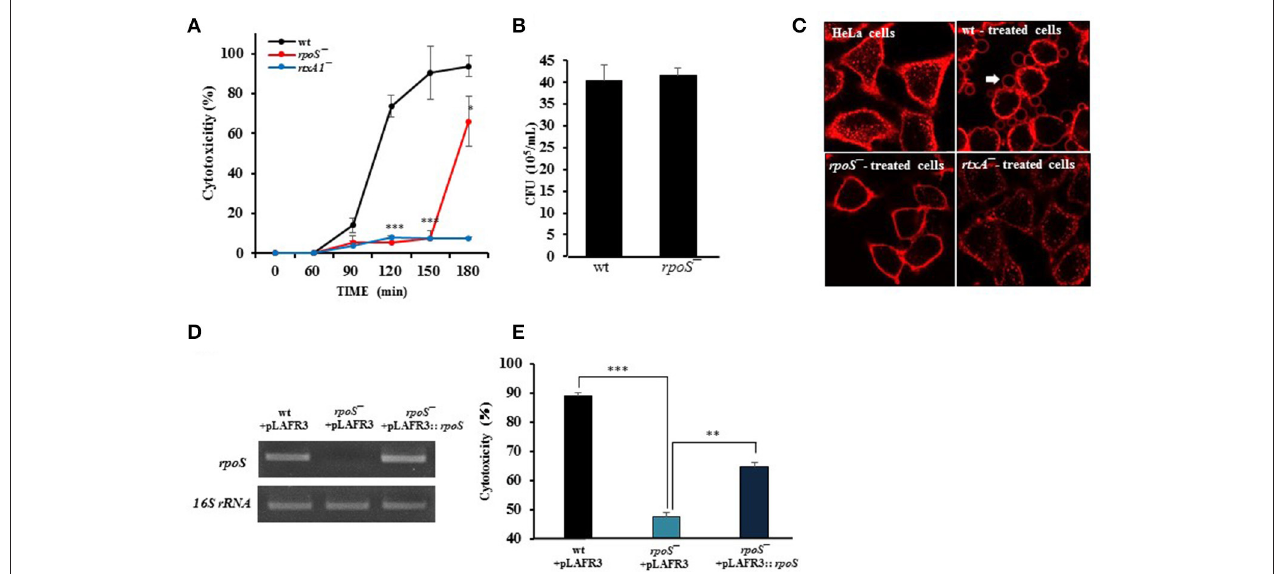
FIGURE 1 | V. vulnificus- induced cytotoxicity and morphological changes in HeLa cells were decreased by an rpoS mutation. (A) HeLa cells in 48-well plates were infected with either V. vulnificus wild-type (wt), an rpoS mutant ( rpoS − ), or an rtxA1 mutant ( rtxA1 − ) strains at an MOI of 20. Lactate dehydrogenase released into the culture supernatant was assayed as a marker of cytotoxicity. (B) HeLa cells in 24-well plates were infected with V. vulnificus strains at an MOI 20 for 120min. The bacterial suspension 10-fold serially diluted (10 µ L) were loaded on HI agar plates overnight and the viable bacterial cells were counted. (C) HeLa cells cultured in an 8-well-chambered coverslip were infected with V. vulnificus strains at an MOI of 100 for 75min. The cytoplasmic membranes were stained with Alexa Fluor 594-conjugated WGA (red color). (D) Restoration of the rpoS gene expression in the rpoS complemented strain ( rpoS − + pLAFR3:: rpoS ) was determined by conventional RT-PCR. The 16S rRNA housekeeping gene was used as an internal control. The fragments were resolved by electrophoresis on 1% agarose gel. (E) HeLa cells were infected with V. vulnificus strains with vector pLAFR3 at an MOI of 20 for 180min, and the cytotoxicity was measured by LDH assay. Results represent the average of at least three independent experiments. Values are means ± SD (vs. V. vulnificus wild-type, ** P < 0.01, *** P <